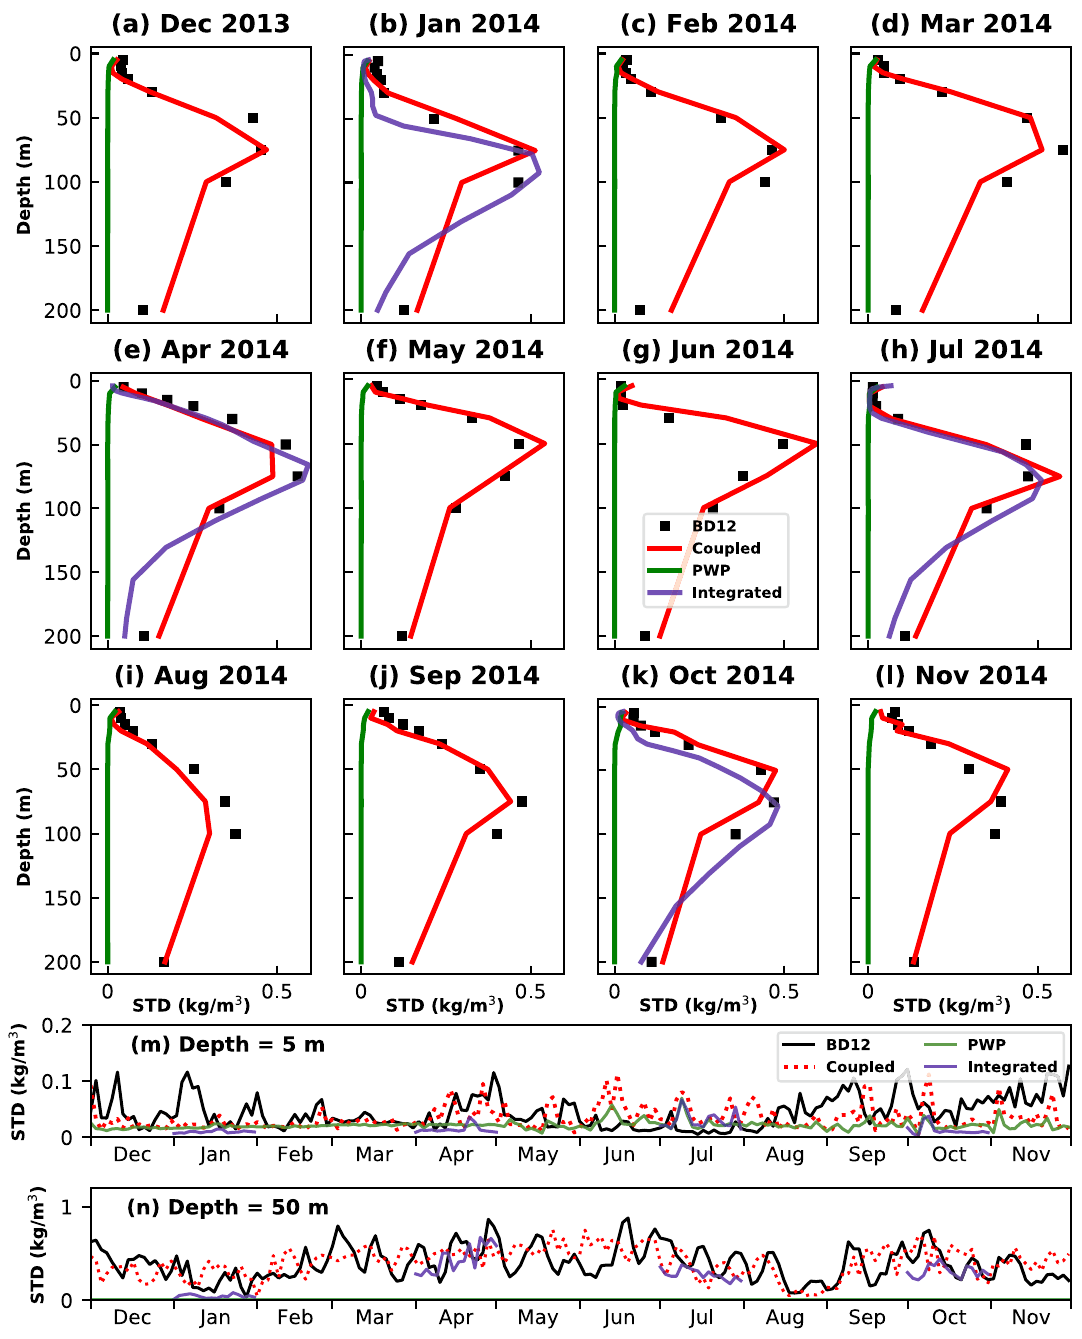
Figure 3. ( a – l ) Comparison of monthly-averaged daily standard deviation profiles of density between BD12 observations (black), Coupled model (red), PWP model (green), and Integrated model (blue). Time-series of daily standard deviation at ( m ) 5 m and ( n ) 50